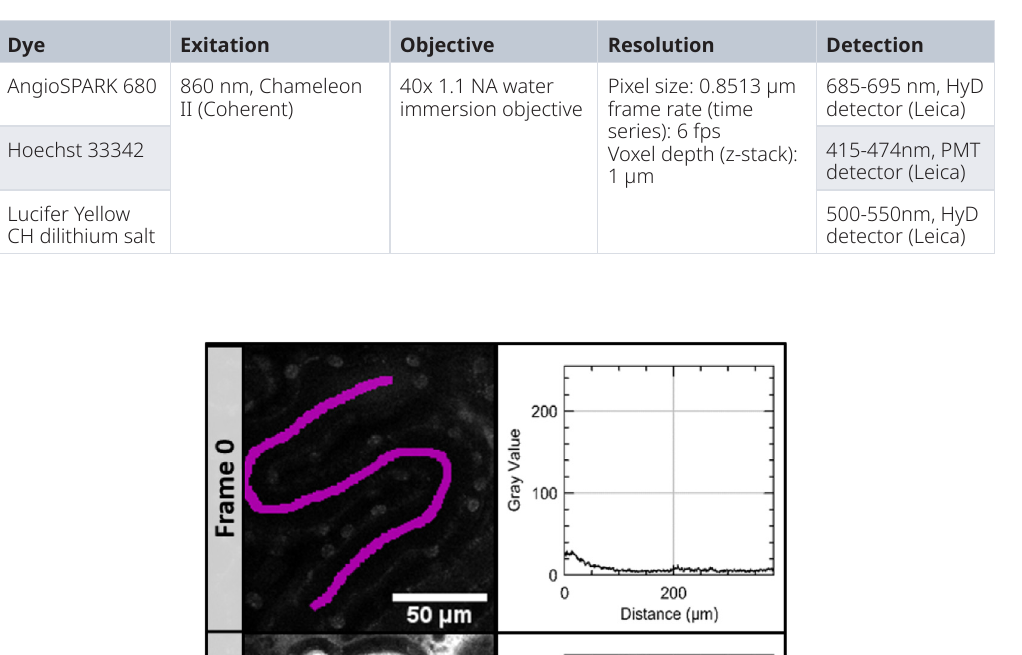
Table 2. Image acquisition settings.